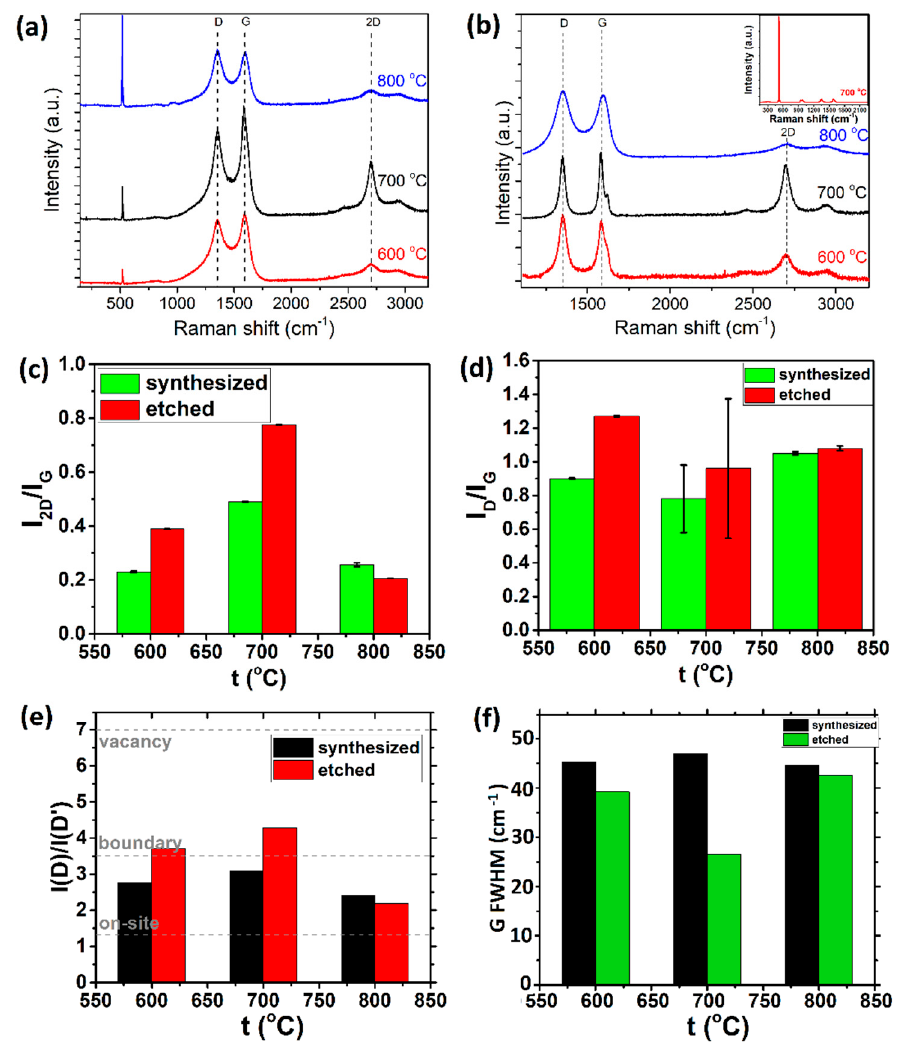
Figure 3. The synthesis temperature effects on the structure of graphene, grown by direct cobalt- assisted single step ion beam synthesis: the Raman spectra after synthesis ( a ) and after removing the sacrificial cobalt interlayer ( b ); Raman spectra parameters analyzed: I 2D /I G ( c ); I D /I G ( d ); I D /I D’ ( e ); FWHM(G) ( f ). The Co layer was 25 nm thick, ion beam energy—800 eV, ion beam treatment time—15 min.